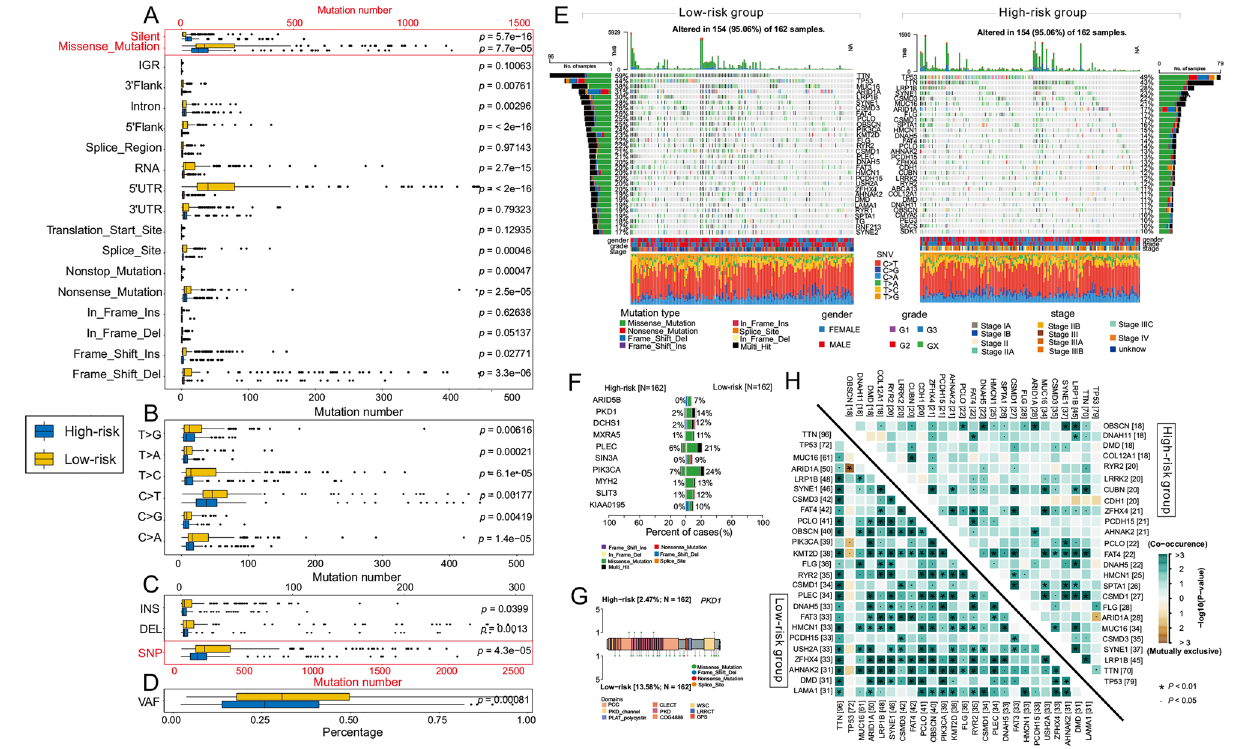
Figure 7. Landscape of somatic mutation in high-risk group and low-risk group. Boxplots show the comparisons of mutation numbers of mutation type ( A ), SNV ( B ), INDEL and SNP ( C ), and the percentage of VAF ( D ) between high-risk group and low-risk group. ( E ) Waterfall plot shows the mutation distribution of the top 25 most frequently mutated genes in high-risk group and low-risk group. The central panel shows the mutation type in each STAD sample. The lower part shows the clinical features (gender, grade and stage) and SNV types of each sample. The bottom panel denote the legend for mutation types and clinical features. ( F ) Forest plot displays the top 10 differentially mutated genes between two groups. ( G ) The lollipop plot illustrates the different mutation pattern in PKD1 . ( H ) The co-occurring and exclusive mutations of the top 25 most frequently mutated genes is illustrated in the